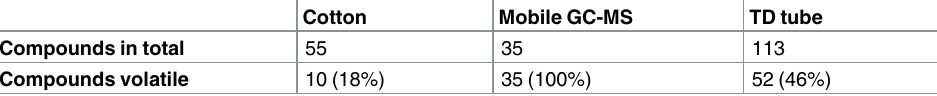
Cotton Mobile GC-MS TD